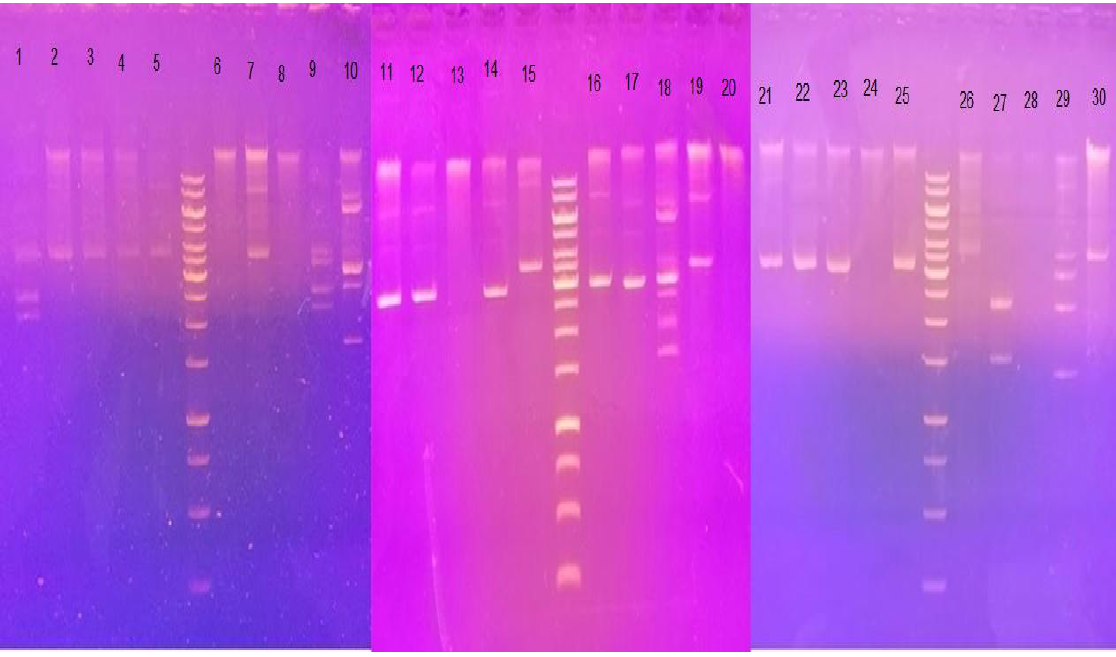
Figure 1. Agarose gel electrophoresis showing banding patterns of the 30 K. pneumoniae isolates by plasmid profile analysis typing method in comparison with the bands of a DNA ladder (ThermoscientificTM O'GeneRuler 1 kb Plus). Lane numbers indicate the code of the tested isolates.